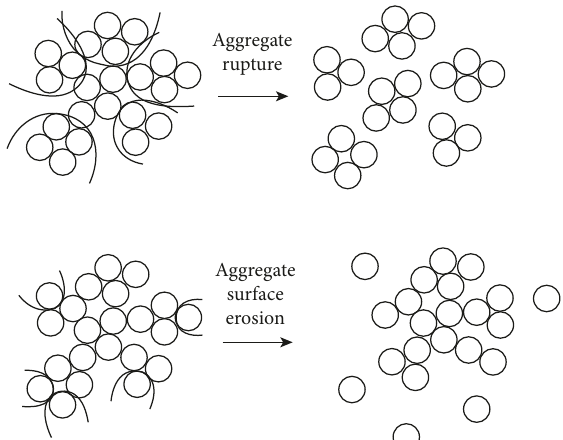
Figure 6: Mechanisms of different breakage modes of flocs. In the case of an aggregate rupture, both size and the perimeter change significantly. In the case of aggregate surface erosion, only the perimeter changes, and size remains almost